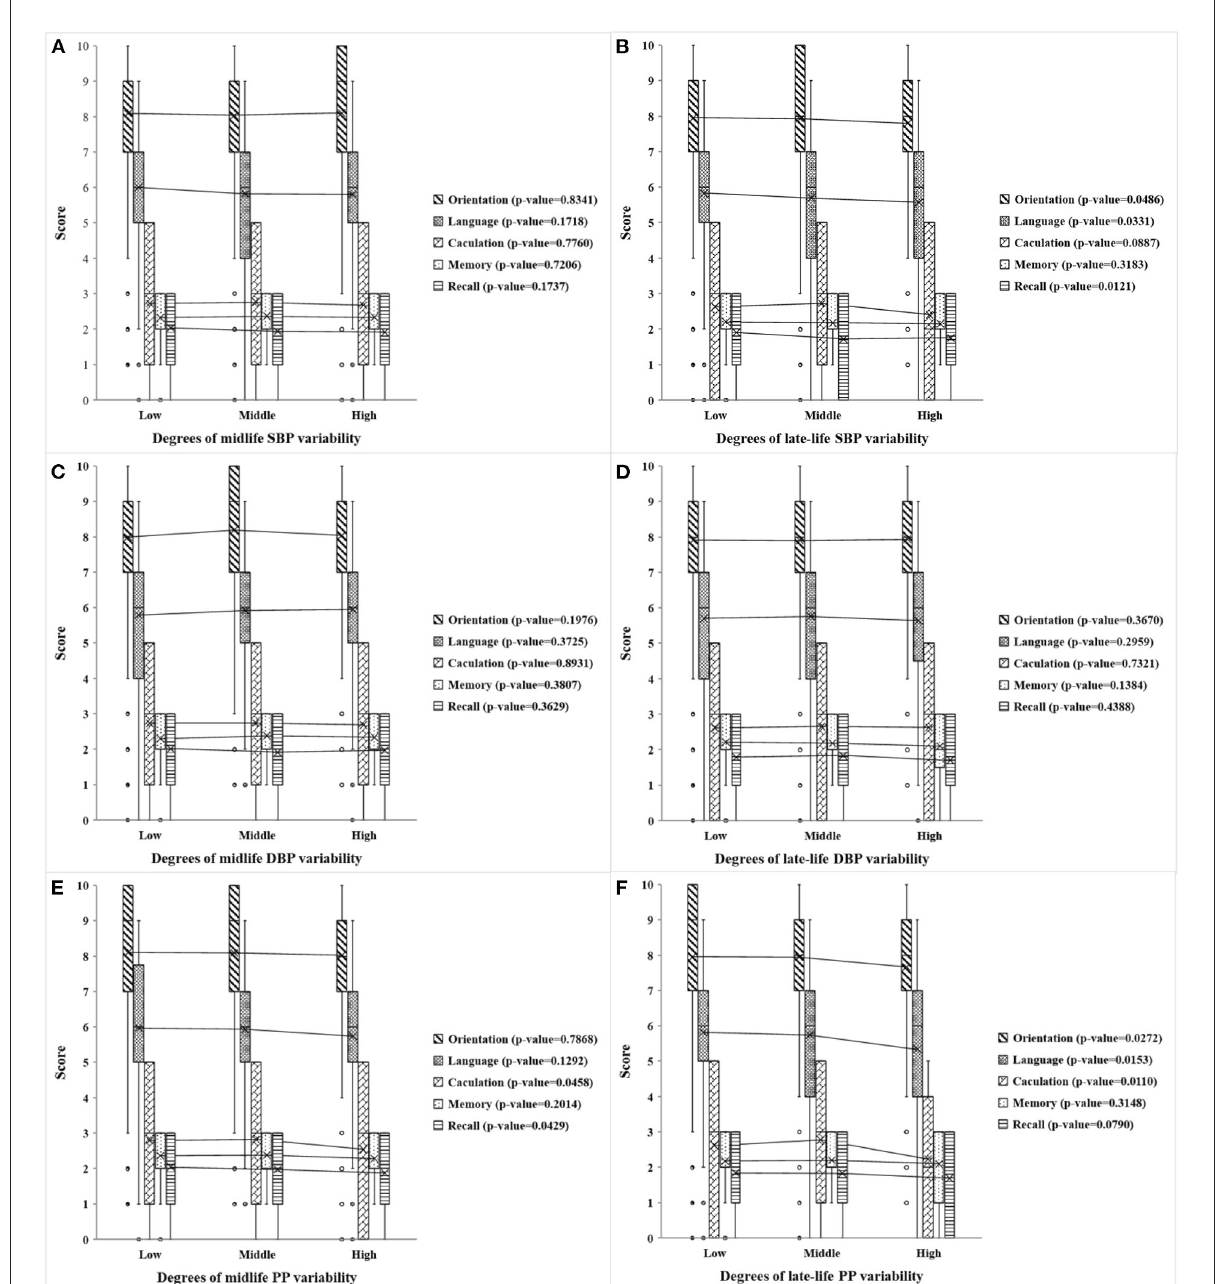
FIGURE3 Scores of the five cognitive dimensions in different degrees of midlife and late-life visit-to-visit BP variability. (A,B) Respectively show the cognitive scores of five dimensions (including orientation, language, calculation, memory, and recall) in different degrees of midlife and late-life visit-to-visit SBP variability, (C,D) respectively, show the scores in different degrees of midlife and late-life visit-to-visit DBP variability, and (E,F) are the scores in different degrees of midlife and late-life visit-to-visit PP variability. The midlife visit-to-visit BP variability is present in the mid-old group, while the late-life visit-to-visit BP variability is present in the old-old group. Visit-to-visit SBP variability, DBP variability, and PP variability were divided by 3rd decile. Low, moderate and high represent the degree of variation. P -value is the analysis of variance of a certain cognitive dimension of different degrees of visit-to-visit BP